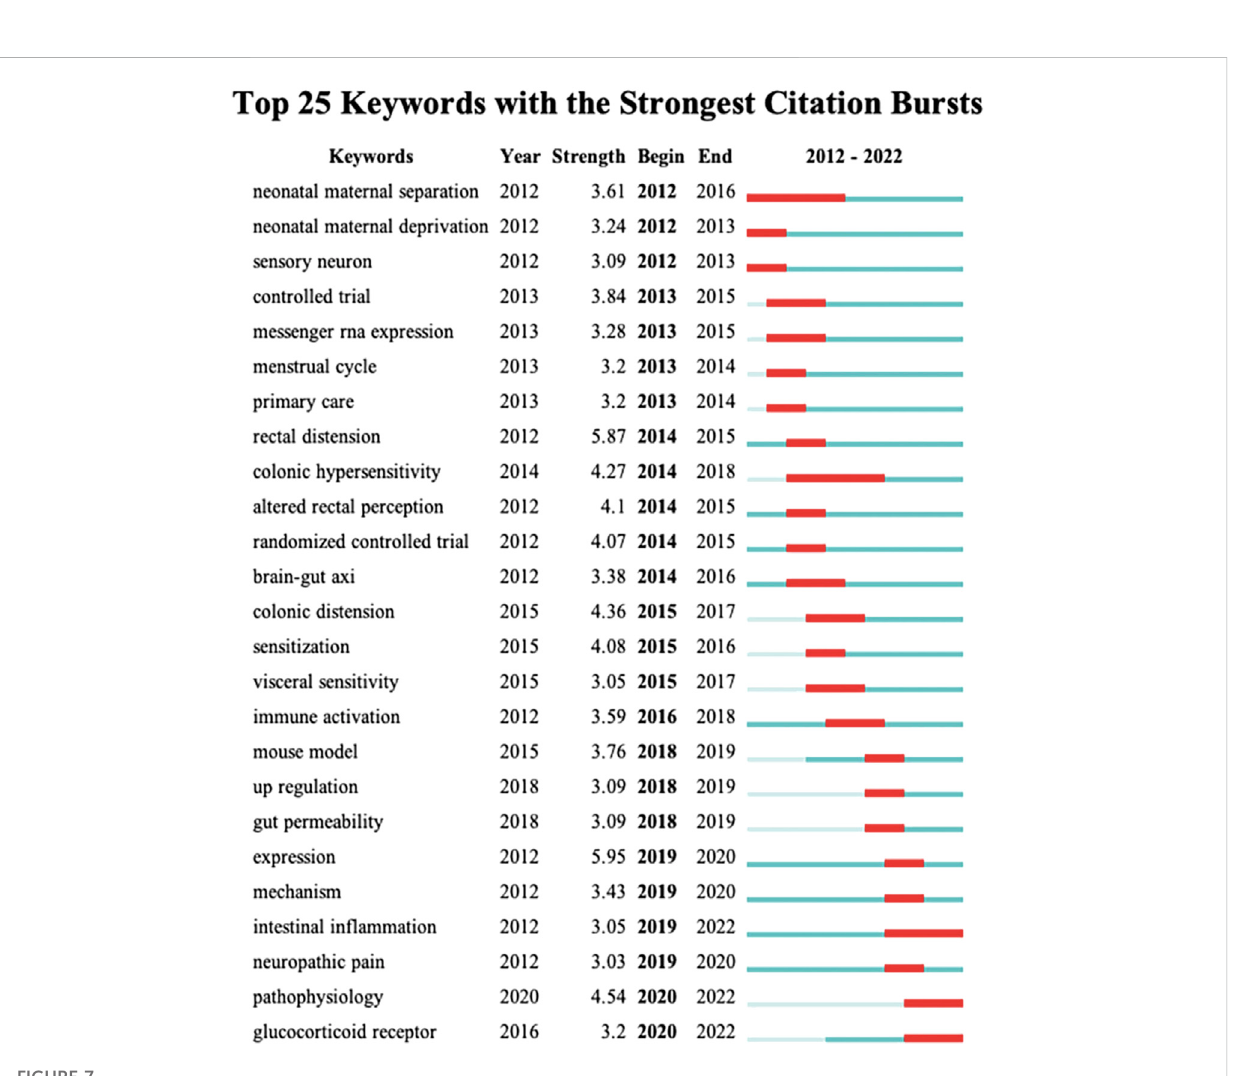
FIGURE 7 Top 25 keywords with the strongest citation